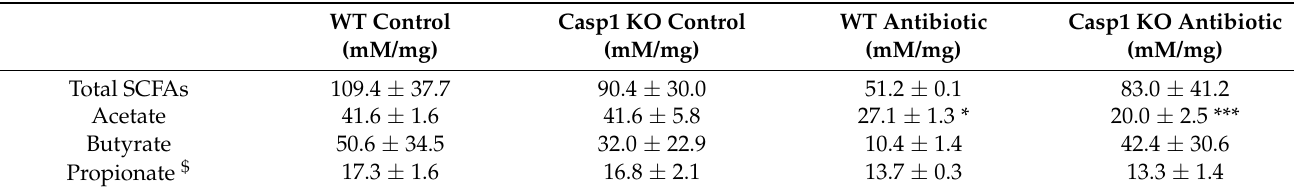
Data are mean (SD). *: p < 0.05 vs. WT Control group. ***: p < 0.0001 vs. Casp1 KO Control group. $ : p < 0.05 general ANOVA difference. n = 2 WT Control and WT-Antibiotic groups; n = 3 Casp1 KO Control group; n = 5 Casp1 KO Antibiotic